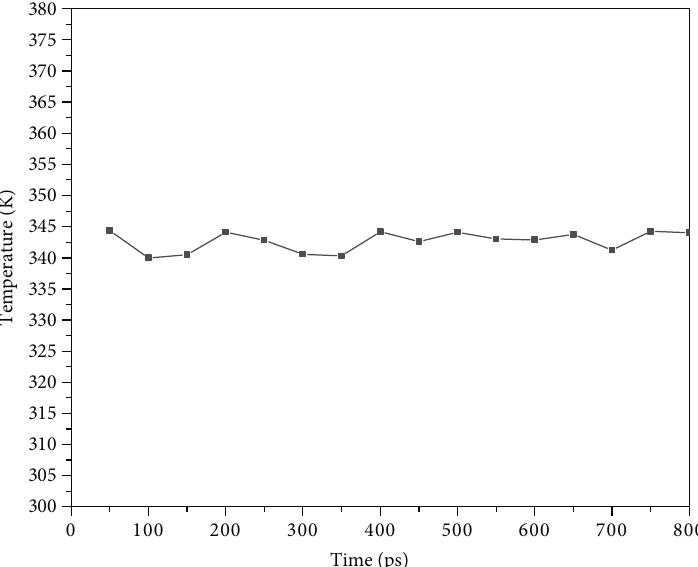
Figure 3: Temperature during NVT